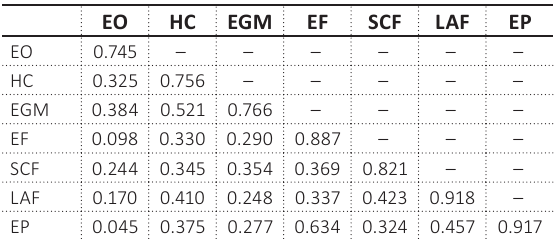
Table 4. Correlations and square roots of AVE